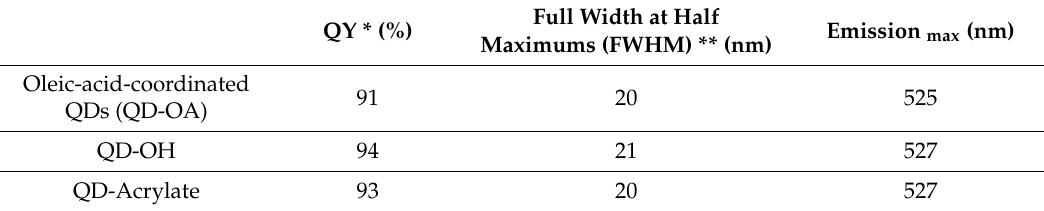
Table 2. Optical properties of the